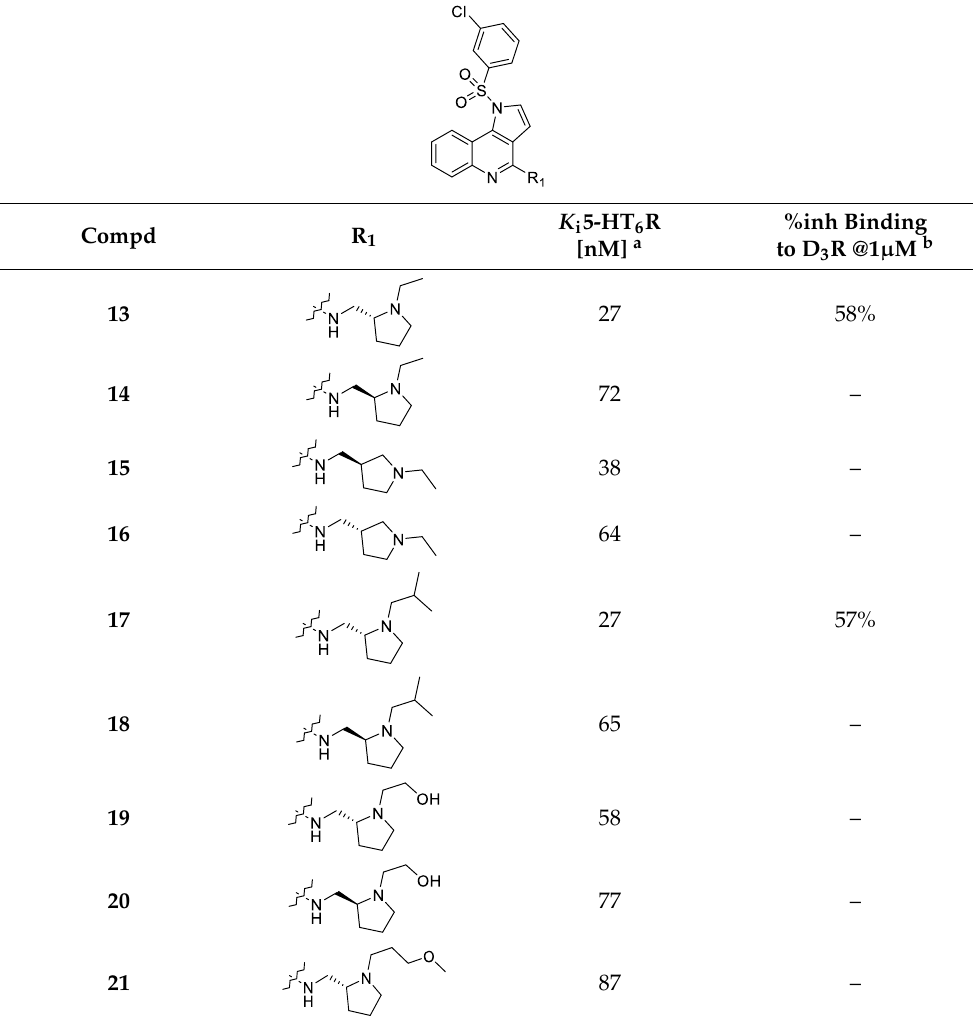
Table 2. Binding data of compounds 13 − 21 for 5-HT 6 and D 3 receptors.